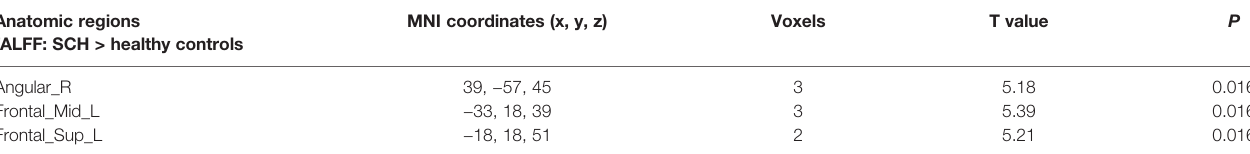
Comparisons were performed at p < 0.05 corrected by False Discovery Rate (FDR) correction. The x, y, and z coordinates indicate the peak locations in the MNI space. MNI, Montreal Neurological Institute Coordinate System or Template; R, Right; L,